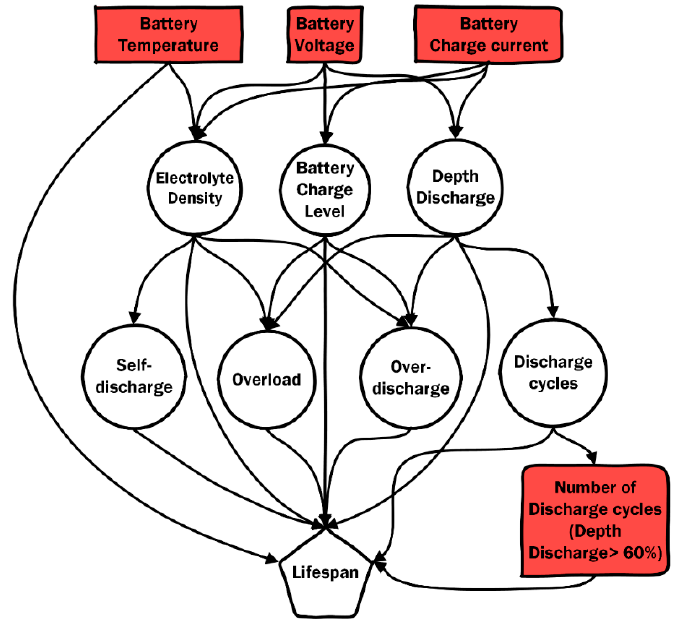
Figure 3. Theoretical Bayesian network model to predict battery lifespan.